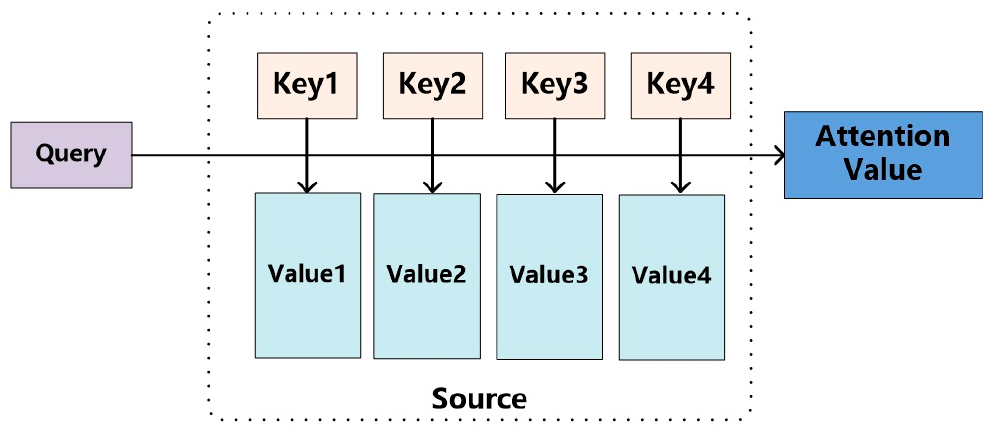
Figure 10. Abstract model of the attention mechanism.